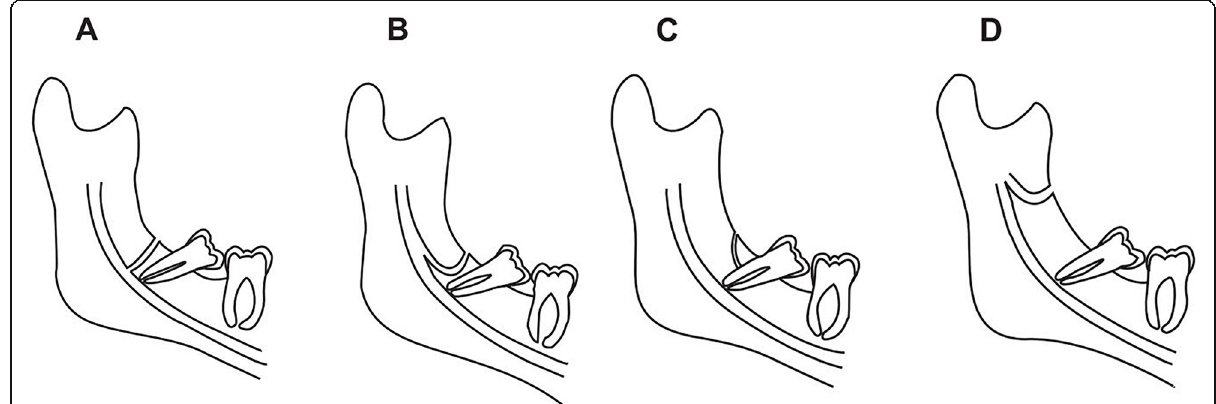
Fig. 4 Classification of RMC. Patil et al. ’ s schematic illustration of different configurations of the retromolar canal. a Type A1. b Type A2. c Type B. d Type C